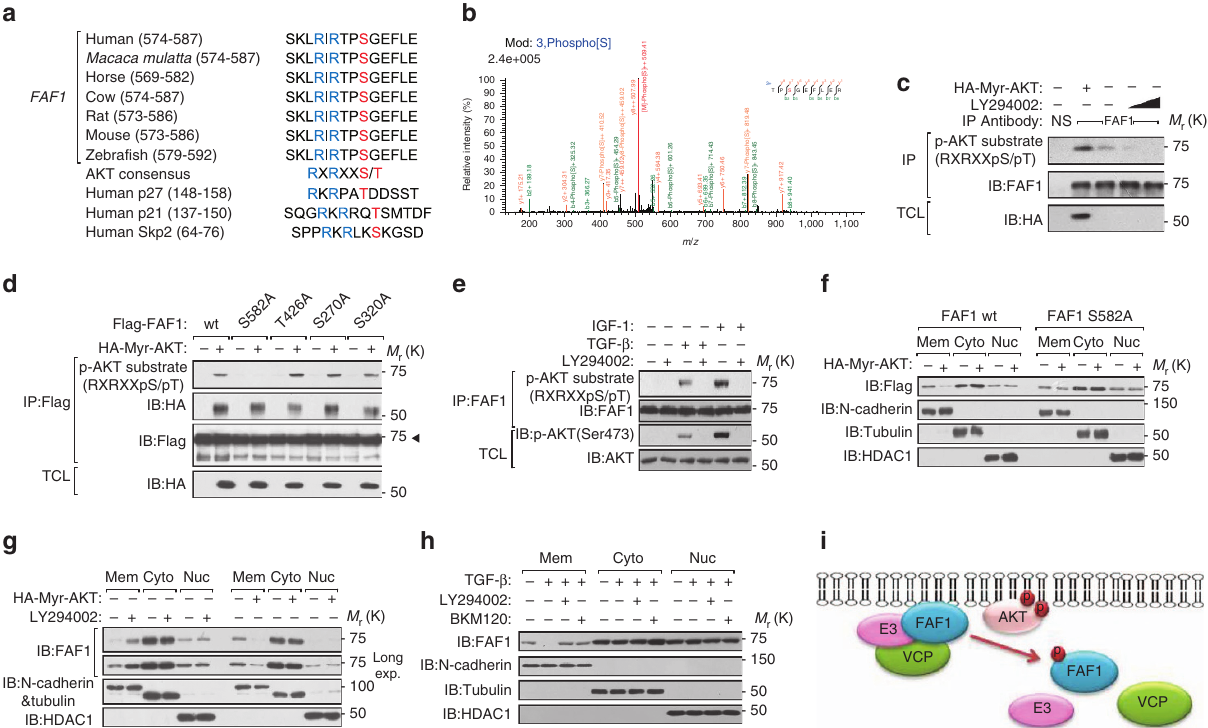
Figure 6 | AKTphosphorylates FAF1 at Ser 582 and inhibits its membrane localization. ( a ) Sequence alignment of the AKTphosphorylation site within FAF1 orthologs from different species and the known AKT-phosphorylating proteins p27, p21 and Skp2. ( b ) AKT-phosphorylated FAF1 peptide identified by mass spectrometry analysis. ( c ) Immunoblot (IB) of total cell lysate (TCL) and immunoprecipitants derived from HeLa cells transfected with Myr-HA-AKT and treated with increasing doses of LY294002 (25 and 50 m M) for 12h as indicated. NS, non-specific antibody. ( d ) HEK293Tcells were transfected with Flag-FAF1 wt or S582A, T426A, S270A or S320A mutants along with Myr-HA-AKT expression plasmids as indicated. Cells were then collected for immunoprecipitation (IP) and IB analysis. ( e ) IB analysis of TCL and anti-FAF1 immunoprecipitates derived from serum-starved HeLa cells treated with IGF-1 (200ngml (cid:2) 1 ), TGF- b (5ngml (cid:2) 1 ) and LY294002 (50 m M) as indicated for 8h. ( f ) HeLa cells stably overexpressing FAF1 wt or FAF1 S582A mutant constructs were transfected with or without HA-Myr-AKT as indicated. Cells were then collected for membrane (Mem), cytoplasm (Cyto) and nuclear (Nuc) extraction and IB analysis. ( g ) IB of Mem, Cyto and Nuc extraction derived from HeLa cells transfected with or without HA-Myr-Akt and treated with LY294002 (50 m M for 12h) as indicated. ( h ) HeLa cells were treated with TGF- b (5ngml (cid:2) 1 ) and selective PI3K inhibitors LY294002 (50 m M) or BKM120 (1 m M) as indicated for 8h. Cells were then collected for Mem, Cyto and Nuc extraction and IB analysis. ( i ) Hypothetical working model of AKT-mediated FAF1 phosphorylation: phosphorylated FAF1 does not efficiently attach to the cell surface or associate with the VCP/E3